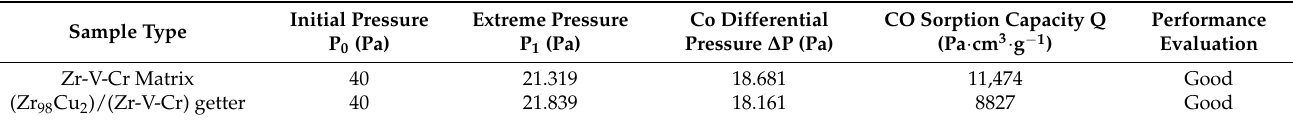
Figure 4. Comparison of CO absorption curves of Zr-V-Cr matrix and (Zr 98 Cu 2 )/(Zr-V-Cr) getter. Table 3. Comparison of CO sorption capacity parameters of Zr-V-Cr matrix and (Zr 98 Cu 2 )/ (Zr-V-Cr)